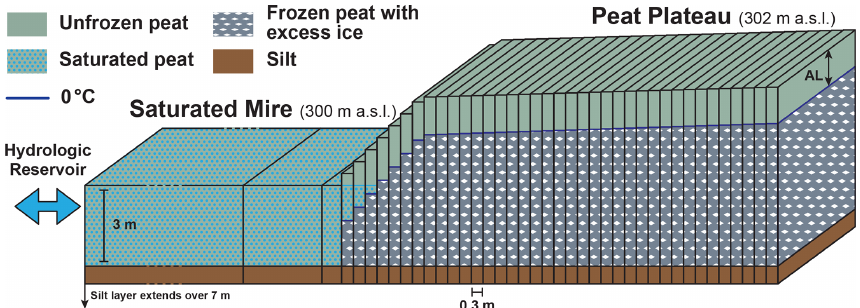
Figure 5. Setup used to simulate peat plateau degradation. We coupled 40 CryoGrid3 tiles to reproduce the contact between the mire and the peat plateau. The surface elevation was linearly interpolated between 300 and 302ma.s.l. over a lateral distance of 2.4m to represent a typical geometry of peat plateau edge. AL stands for active layer. We linearly interpolated them between 0.9 (leftmost tile) and 0.7m (rightmost tile). The model implements lateral fluxes of snow, subsurface water and heat between the tiles as well as ground subsidence due to excess ice melt. The bottom part of the setup has been truncated because it consist of silt over 7m for all tiles. This setup is an idealized setup derived from our field observations. It does not aim to represent one particular natural setup of the edge transect areas detailed in this study.